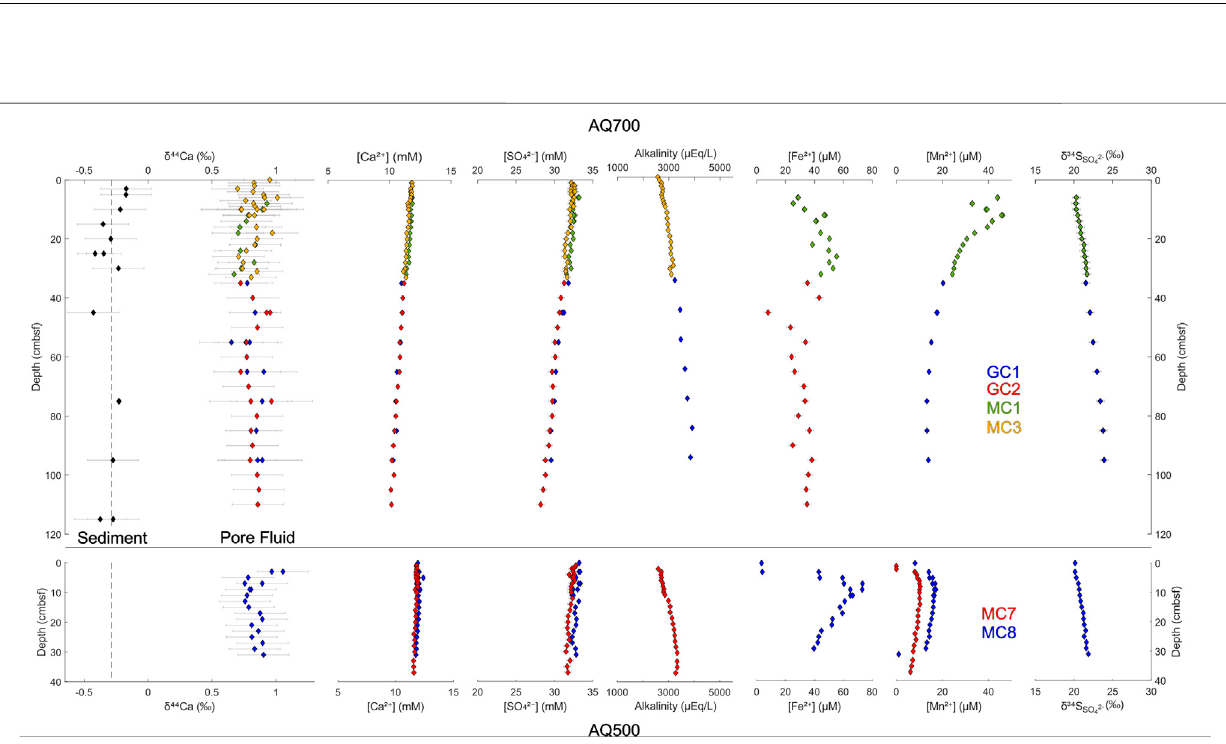
Frontiers in Earth Science |